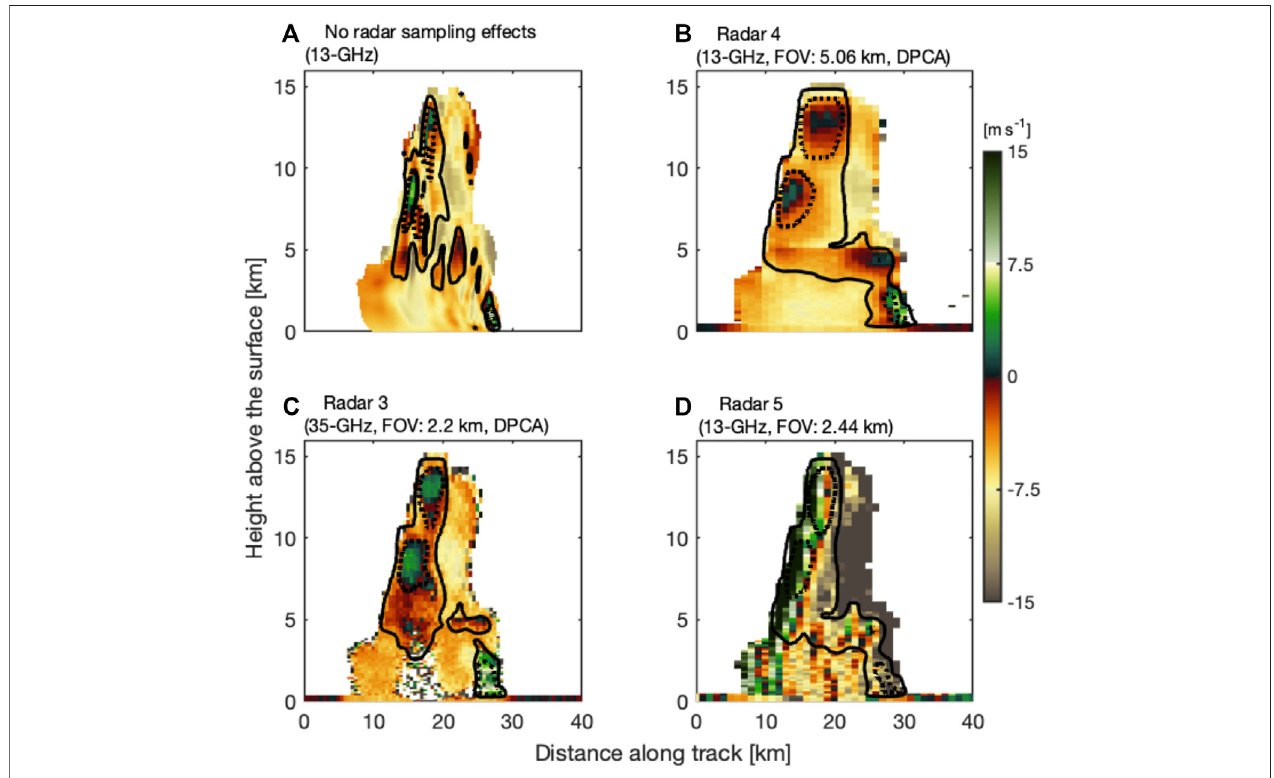
FIGURE10| ForwardsimulationofTRMM-LBAweaklyorganizedconvection (A) meanDopplervelocityat13GHzwithoutradarsamplingeffects(i.e.,truth)aswell as mean Doppler velocity for (B) radar 4, (C) radar 3, and (D) radar 5. Overlaid on each plot are air motion contours drawn from forward-simulations with no platform motion effects (2 m s − 1 : solid and 8 m s − 1 : dotted). Radar re fl ectivity was presented in Figure 6 .